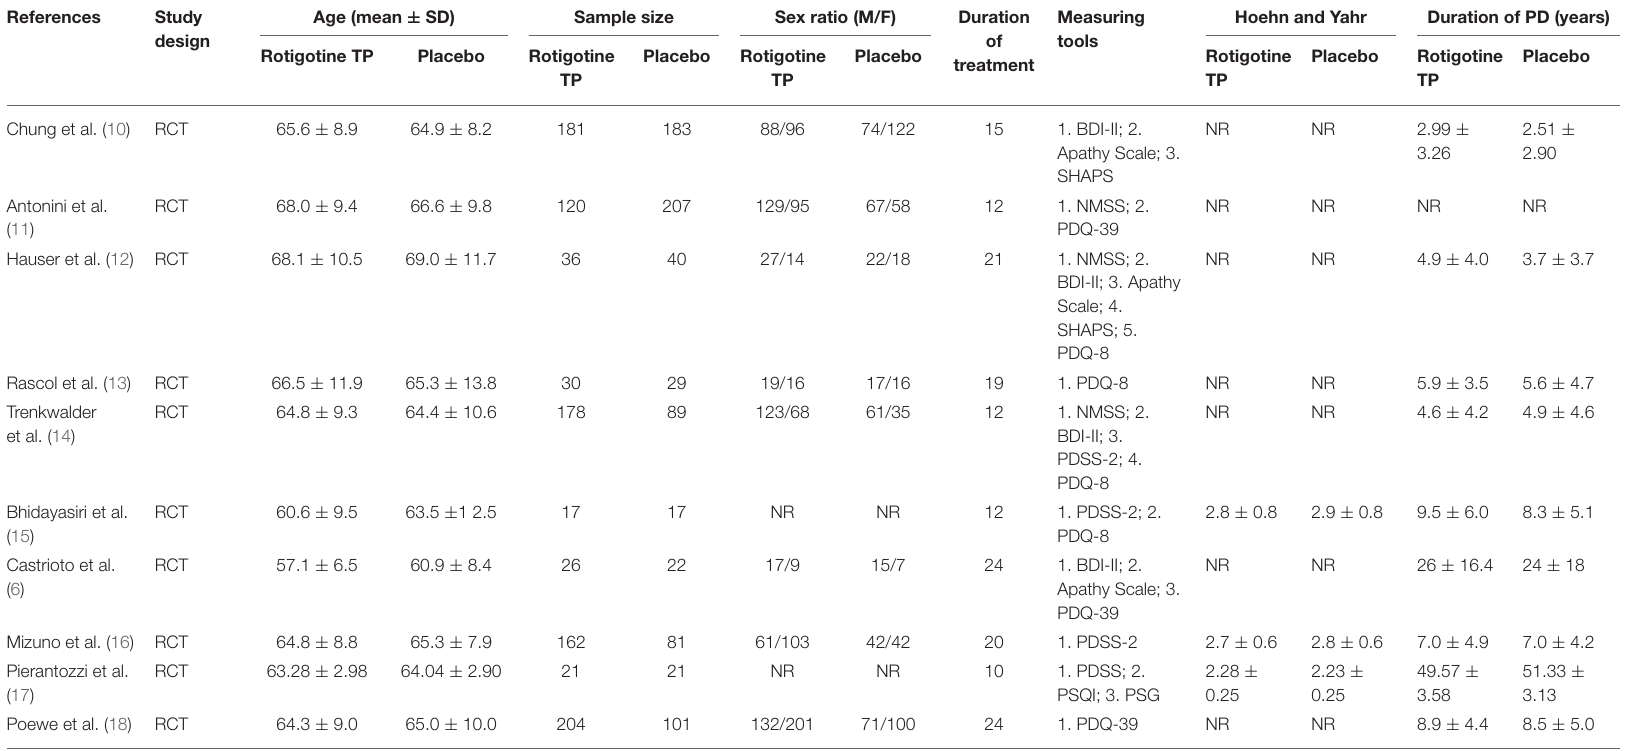
TABLE 1 | Basic characteristics of the included